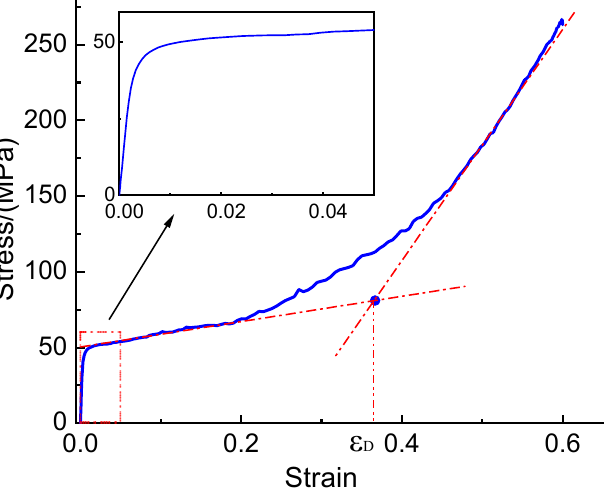
Figure 4. Compressive stress ‐ strain curve of porous aluminum alloy. The strain is slight for the elastic region, and the elastic modulus can be calculated from the straight line, as shown in Equation (1). The plateau region is the primary energy absorption stage, which starts with the yielding of the weakest pore wall and then spreads and produces a yield band (the yield band is shown in the black box in Figure 3c) until it is compacted into the densification region. According to the theory of the literature [21], the end of the plateau region of the porous metal compression curve is also the beginning of the densification section taken as the ultimate strain ε D , which can be approximated by Equation (2):